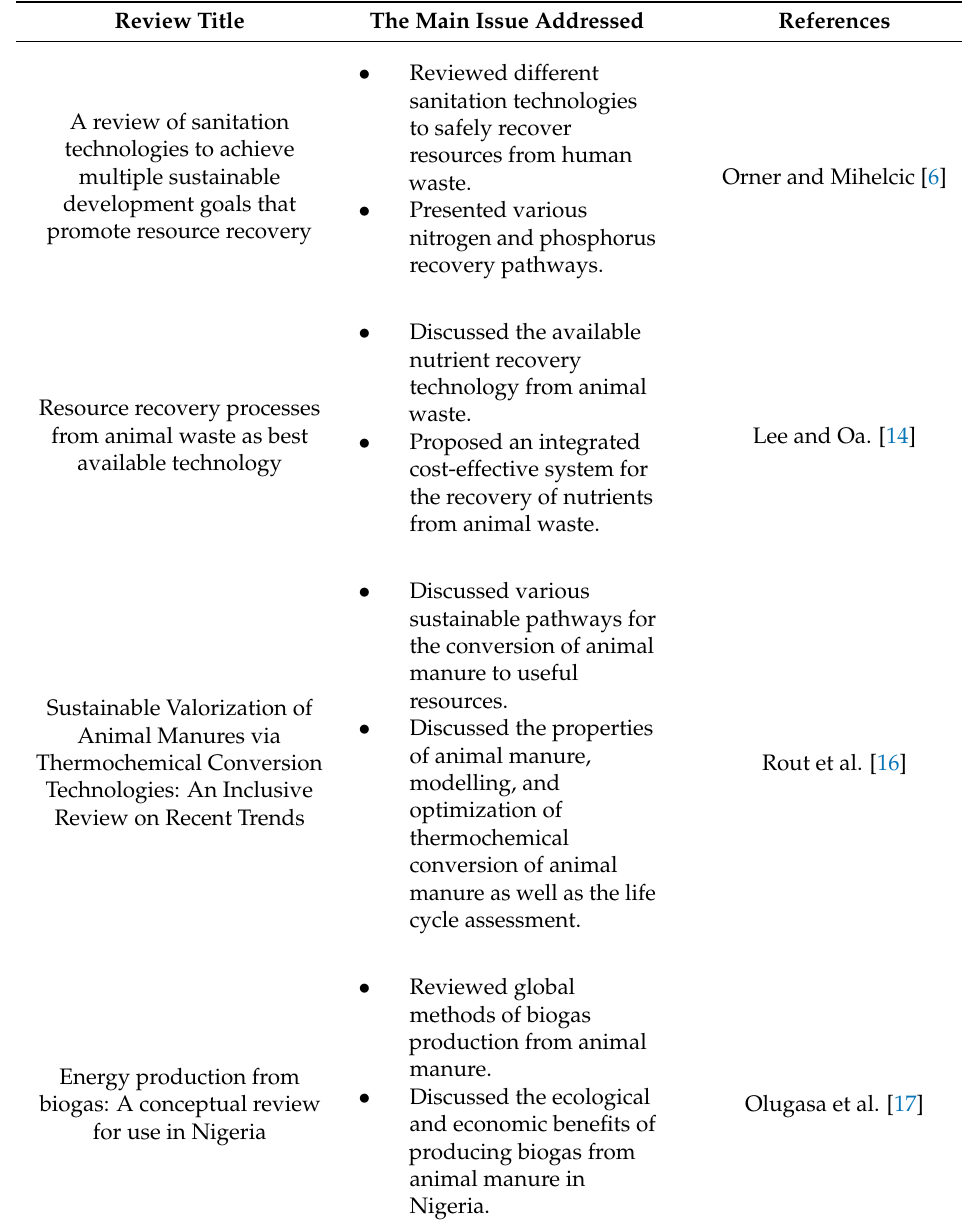
Table 1. Summary of review articles related to resource recovery from human and animal